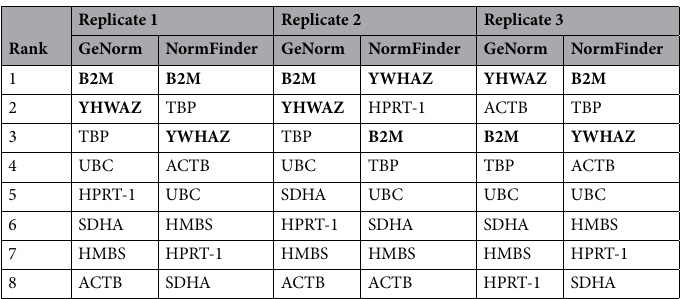
Table 2. Reference gene stability. Ranking of selected reference genes based on stability. Similar to GeNorm, NormFinder is a mathematical algorithm used to identify the best normalization gene according to their expression stability ( M ) 31 . Two consistent most stable references genes are labeled in bold.